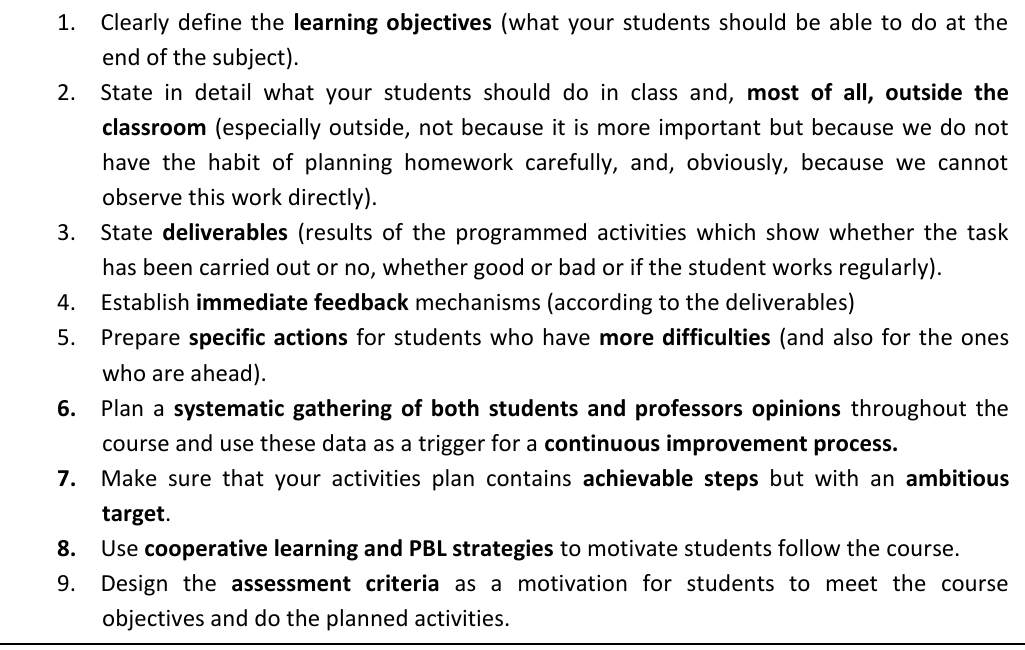
Fig. 1: The 9 criteria which characterize our model of subjects’ adaptation to de